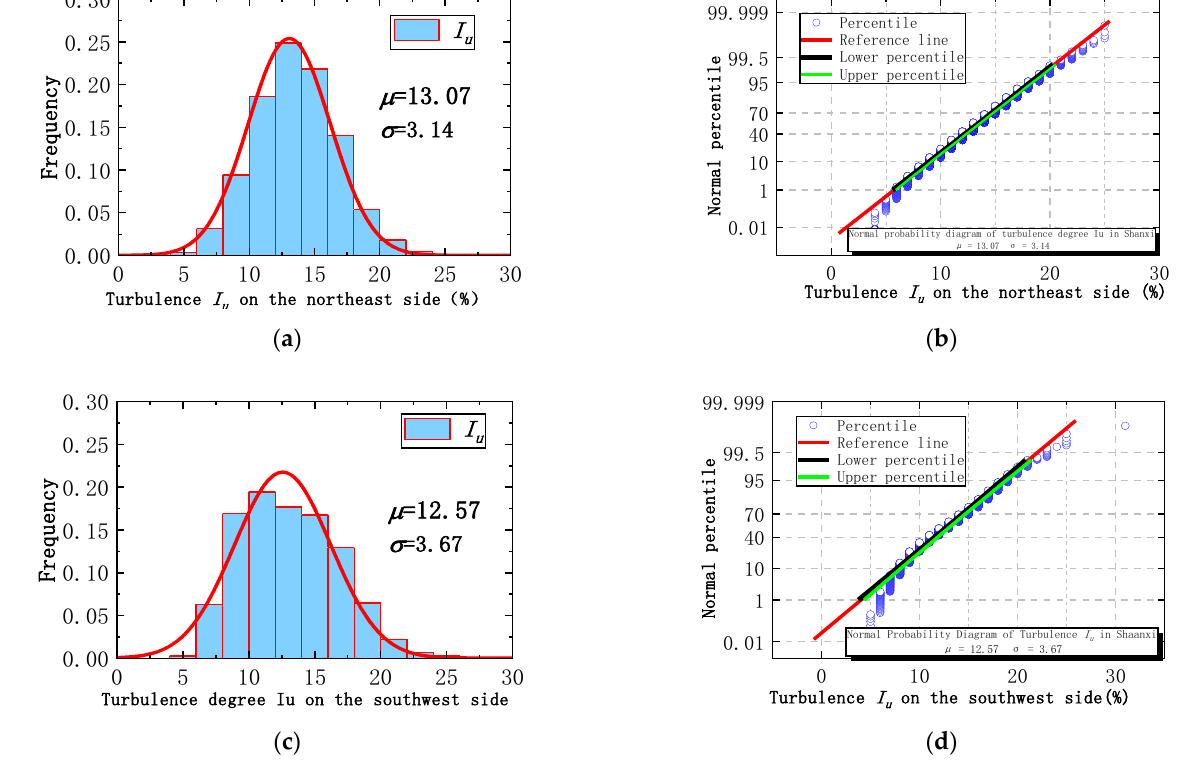
Figure 14. Probability statistics of turbulence I u downwind: ( a ) turbulence degree I u on the northeast side; ( b ) normal probability diagram of turbulence I u on the northeast side; ( c ) turbulence degree I u on the southwest side; ( d ) normal probability diagram of turbulence I u on the southwest side.